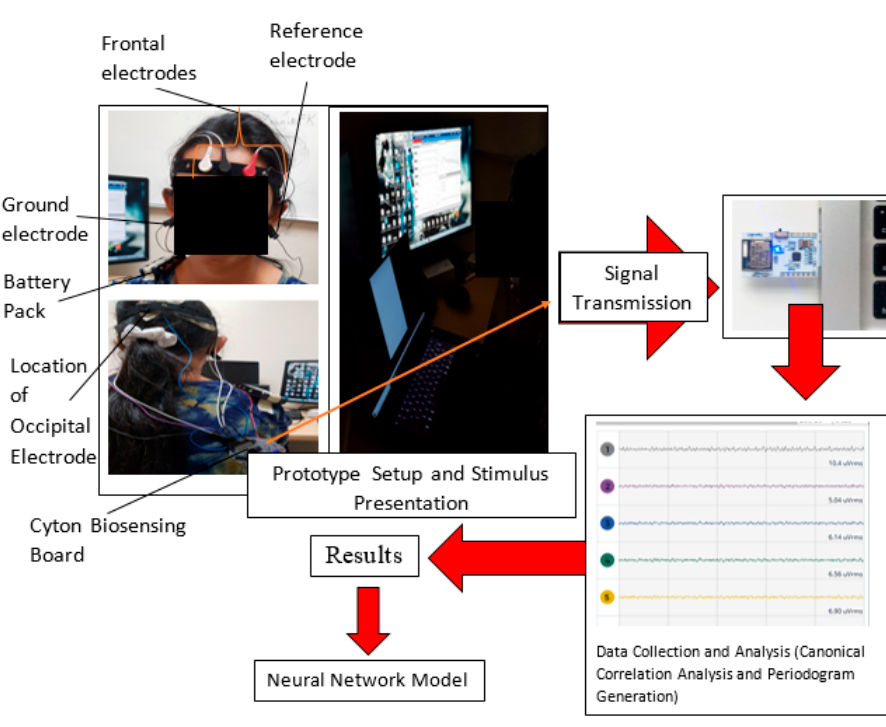
Figure 1. Brain–computer interface (BCI) equipment setup and experimentation .